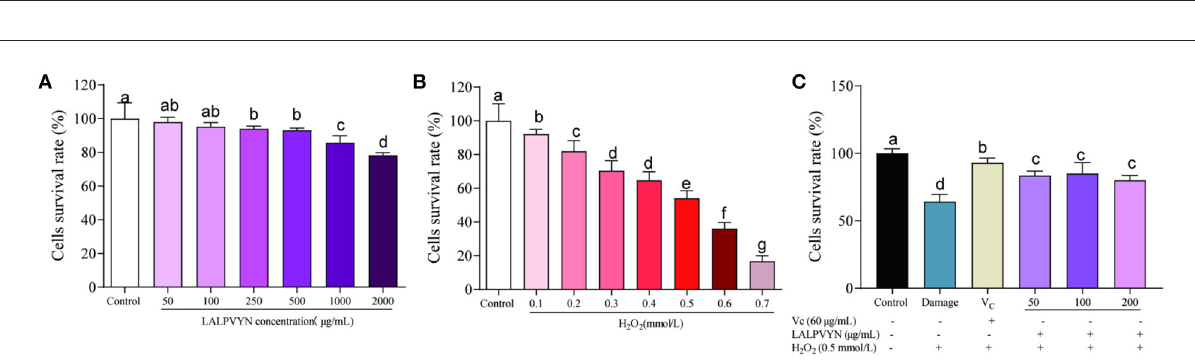
FIGURE4 Effects of LALPVYN pretreatment on the survival rate of H 2 O 2 -mediated oxidative injured HepG2 cells. (A) The survival rates of HepG2 cells treated with LAL at different concentration; (B) the survival rates of HepG2 cells treated with H 2 O 2 at different concentration; (C) the survival rates of HepG2 cells treated with both LALPVYN, V C and H 2 O 2 . Data are expressed as mean ± SD from three independent experiments ( n = 3), results marked with the same letters were not significantly different ( P > 0.05).